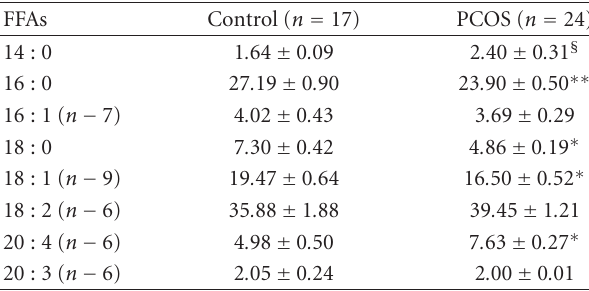
Table 5: The amounts of major free fatty acids (FFAs) as % of total amount in plasma of patients with PCOS. Results were expressed as means ± SEM (compared to control, ∗ P < . 001, ∗∗ P < . 01, § P < .